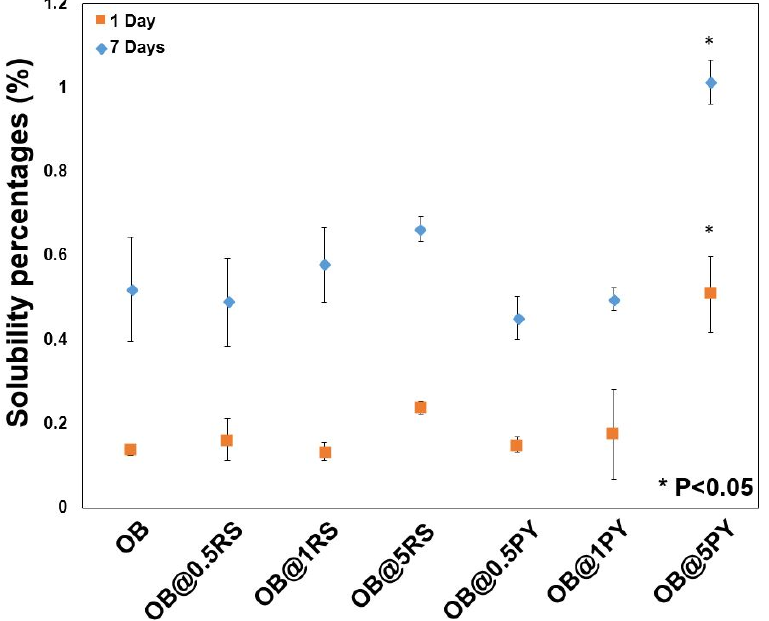
Figure 5. Solubility percentages (wt.%) ( n = 3) of OB and OB modified with different concentrations of RS and PY in distilled water at 37 °C after 1 and 7 days. * p < 0.05.